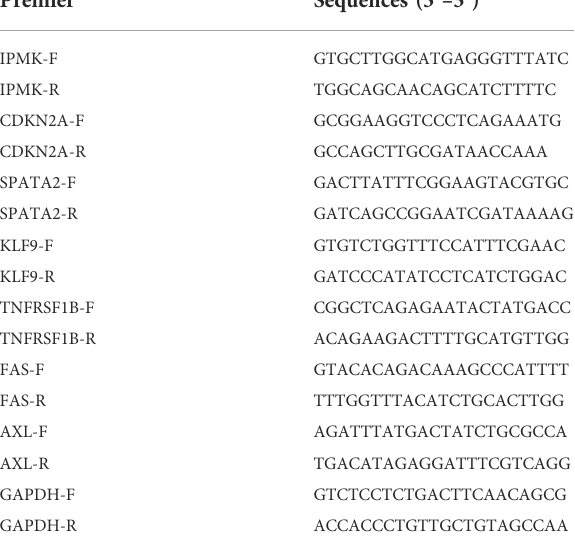
TABLE 3 Premier sequences for qRT-PCR